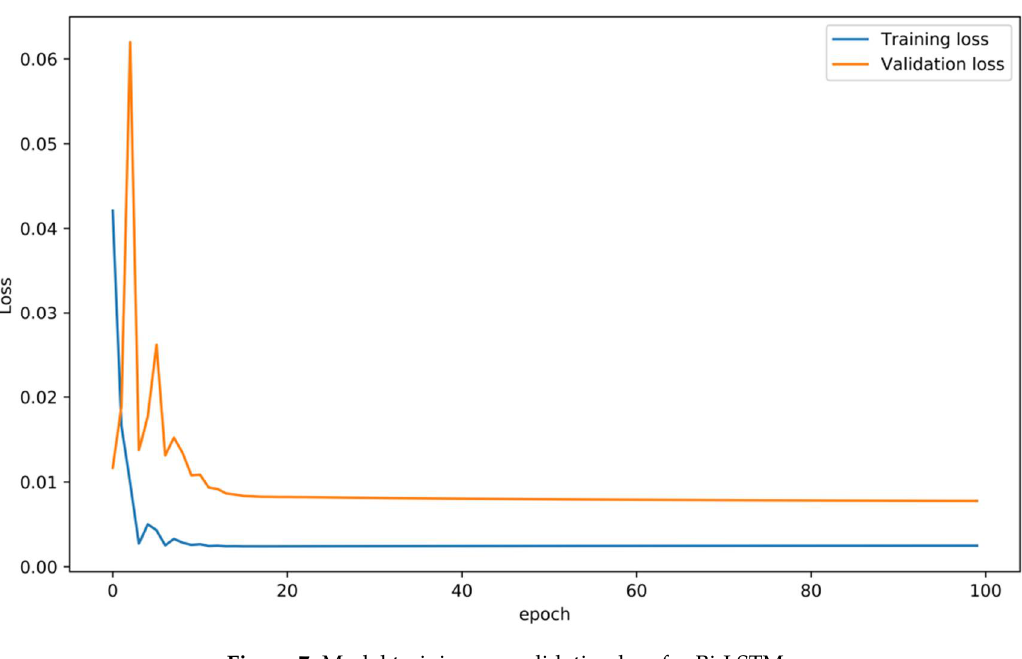
Figure 7. Model training vs. validation loss for Bi-LSTM.